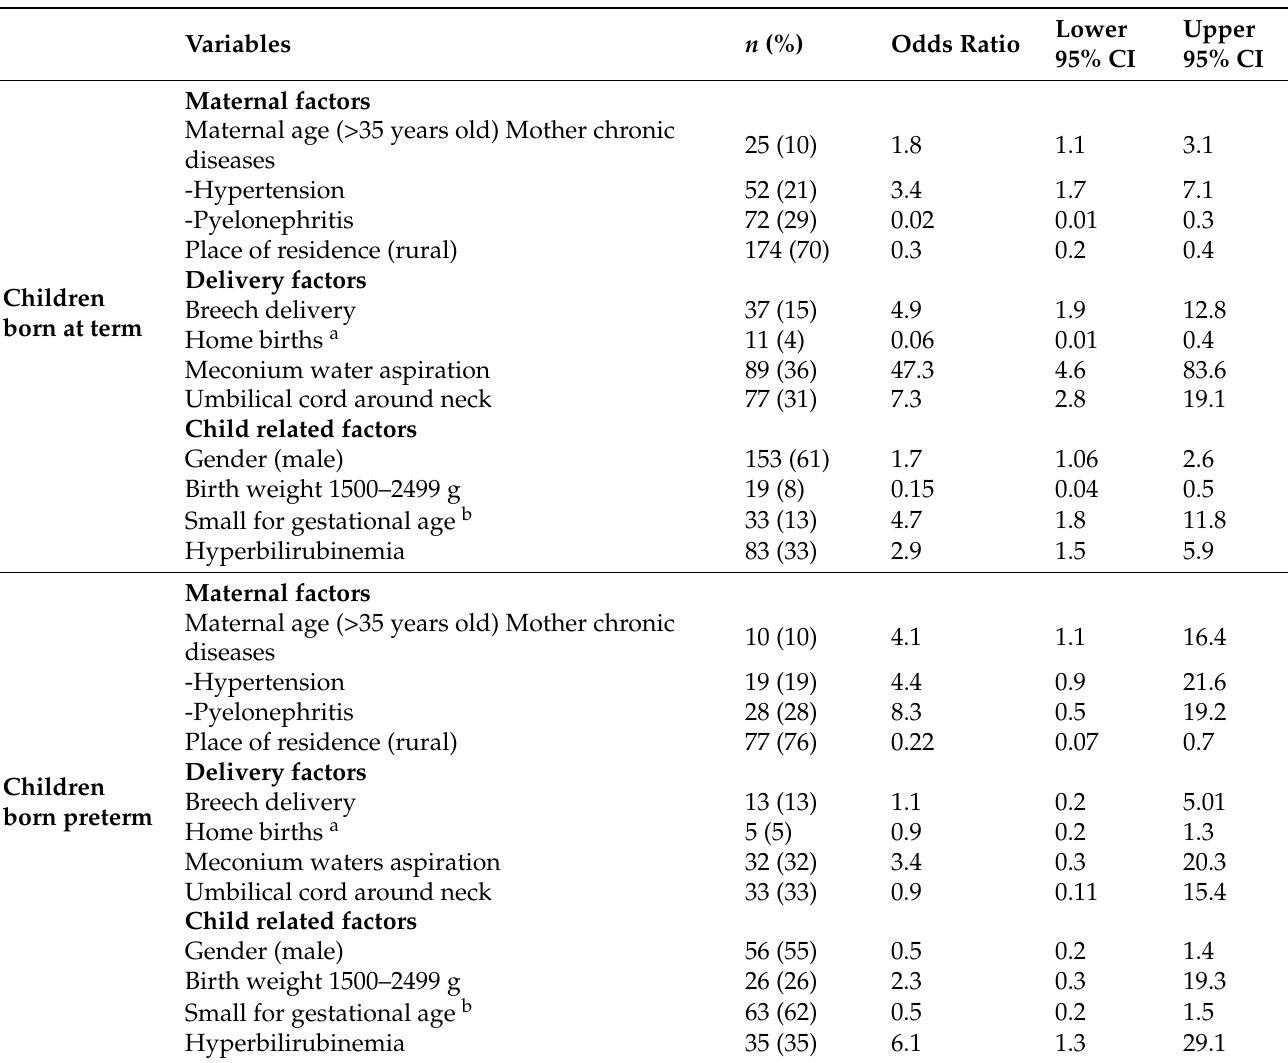
Table 2. Multivariable analyses with confounders of risk factors among term and preterm born children with CP. ( n =